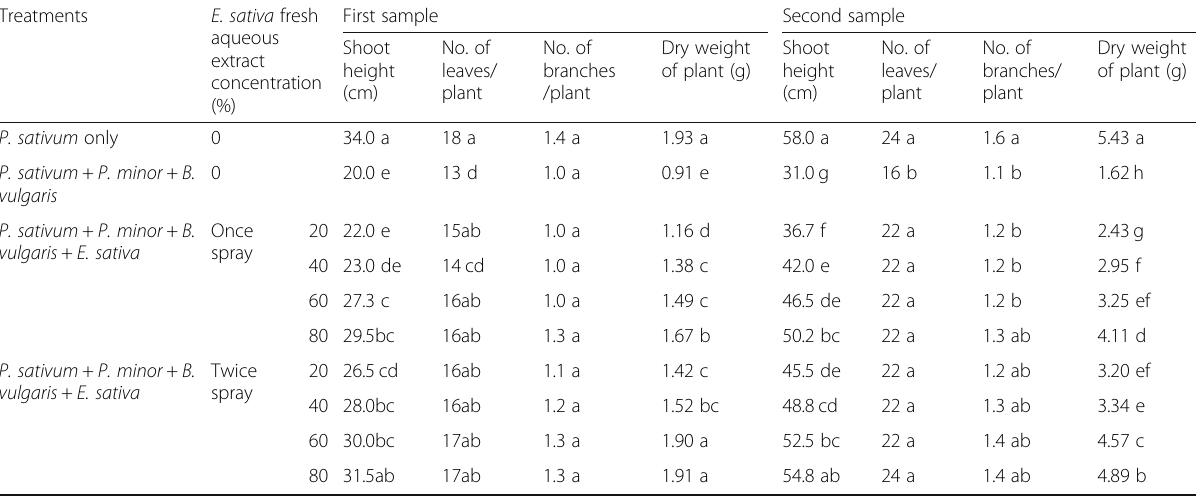
Table 3 Effect of spraying different concentrations of E. sativa fresh aqueous extract on growth parameters of P. sativum plants. (Combined analysis of the two seasons)